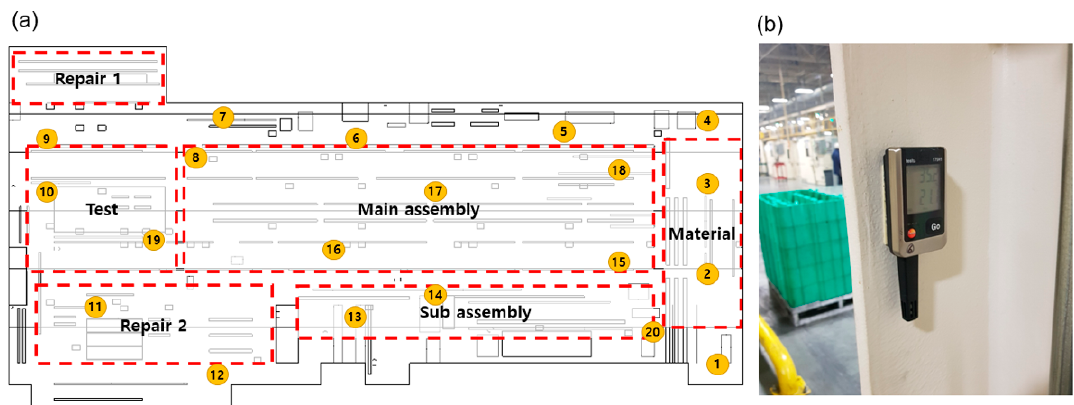
Figure 6. ( a ) Virtual sub zone and temperature measurement points of the large-scale assembly factory; ( b ) Installed temperature and humidity data logger at the measurement point 15.